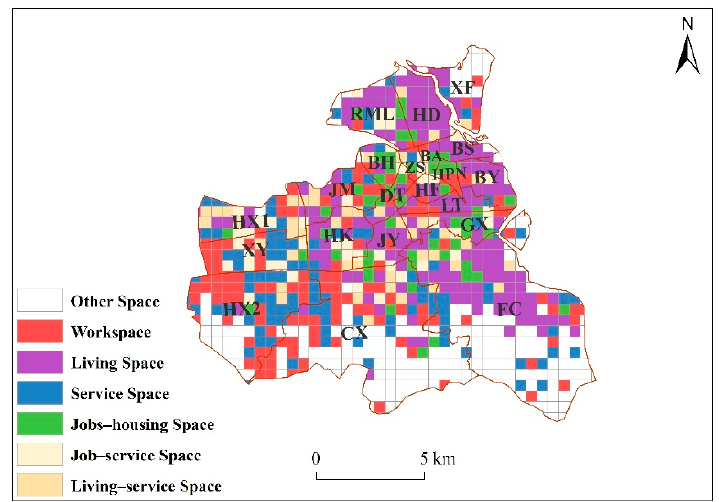
Figure 6. Recognition results of the POI quantitative recognition. As outlined in Table 5, the statistics of the spatial distribution of various functional Table 5. Statistics on the number and density (/km 2 ) of street land areas indicate that workspaces with high density are mainly distributed on the DT, HF, HPN, LT, and ZS streets, among which LT has the highest density with a value of 3.94; living spaces with high density are mainly distributed on the BL, BS, GX, HD, JY, and LT streets, among which JY streets have the highest density with a value of 6.34; service spaces with high density are mainly distributed on streets such as HX1, HX2, XY, etc., with high density are mainly distributed on streets such as BH, DT, and HPN, among